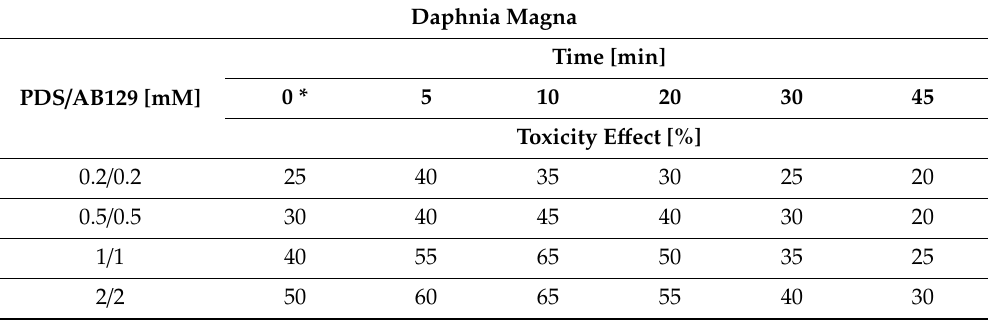
Table 3. Toxicity of AB129 by-products on Daphnia magna (* Time 0 min = samples without PDS addition).